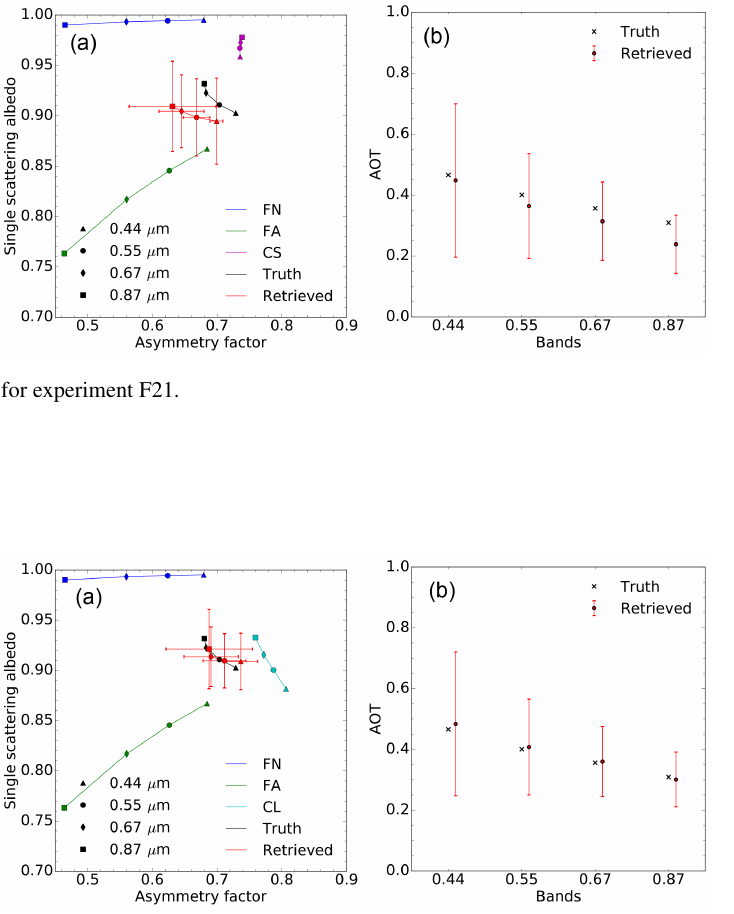
Figure 11. Same as Fig. 5 but for experiment F22.